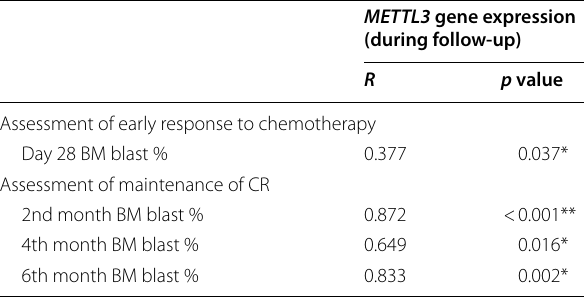
Table 8 Correlation of METTL3 gene expression level to blast count during follow‑up stages for assessment of early response to chemotherapy and maintenance of CR